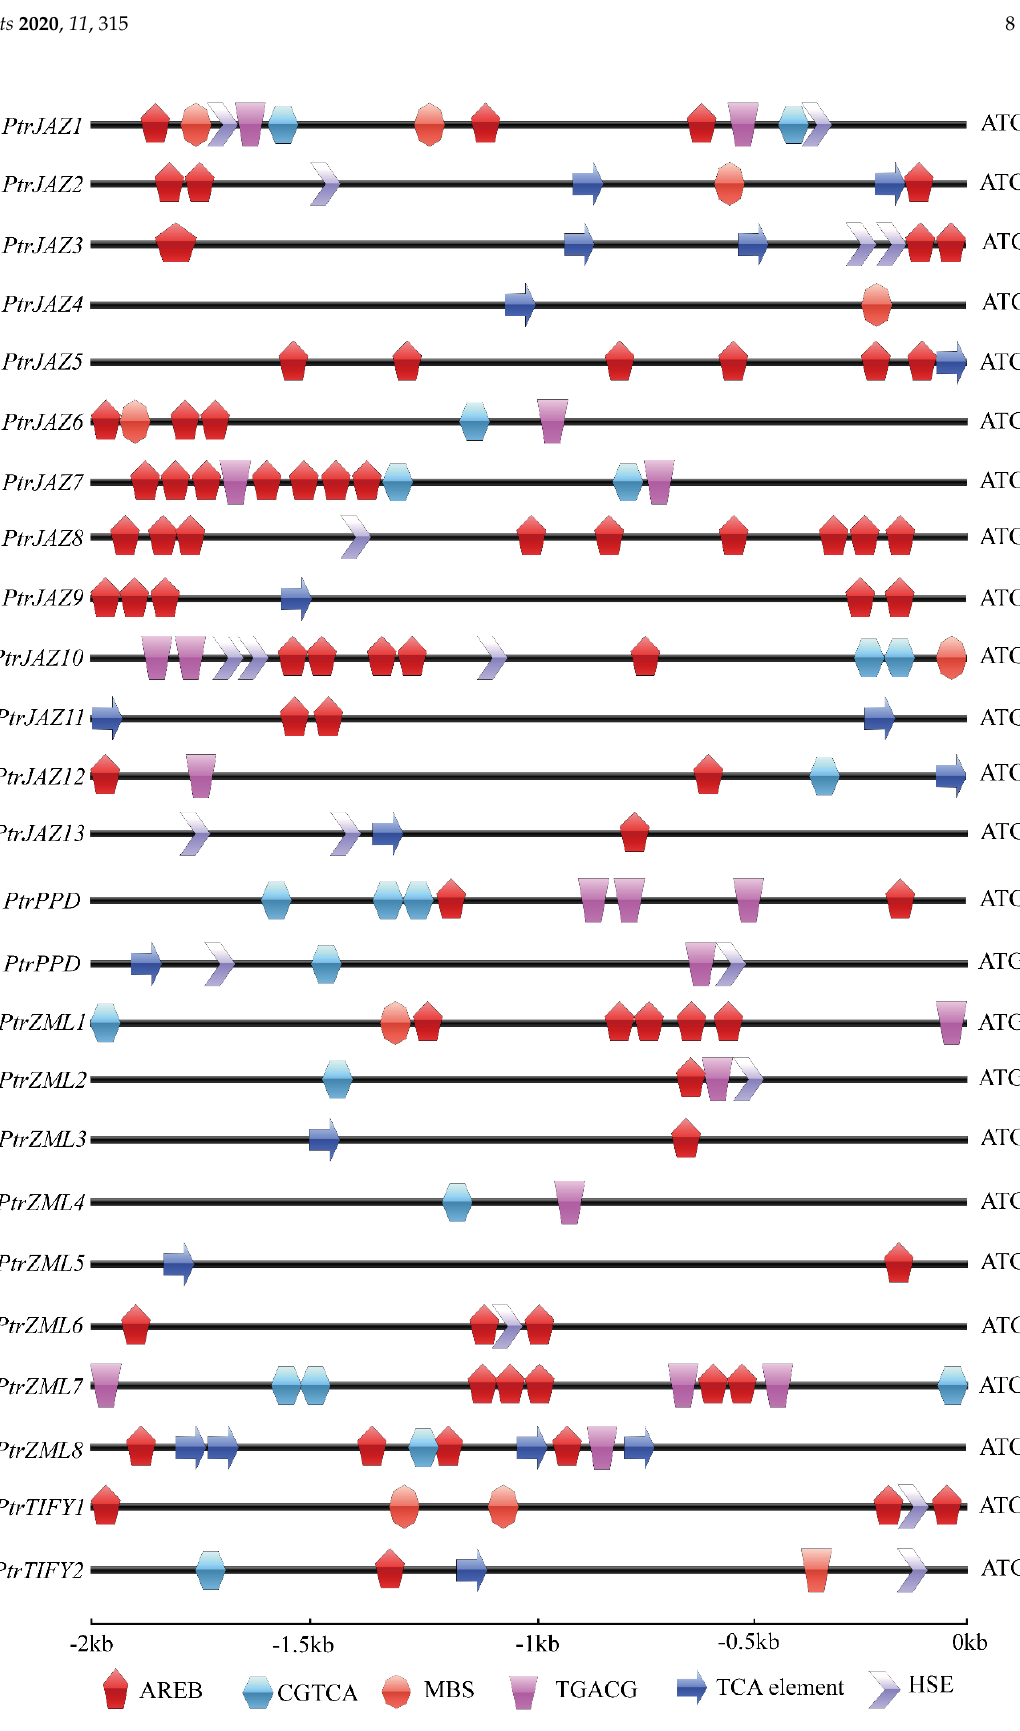
Figure 3. Abiotic stress and phytohormone response elements in PtrTIFY gene promoters.